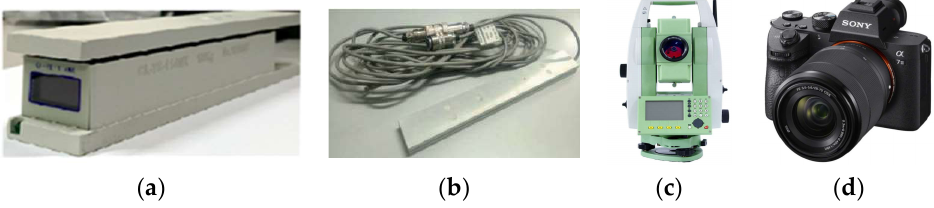
Figure 4. Stress sensors and instruments for the experiment: ( a ) Wireless stress sensor. ( b ) Ultra-thin pressure sensor. ( c ) Leica total station. ( d ) HD camera.